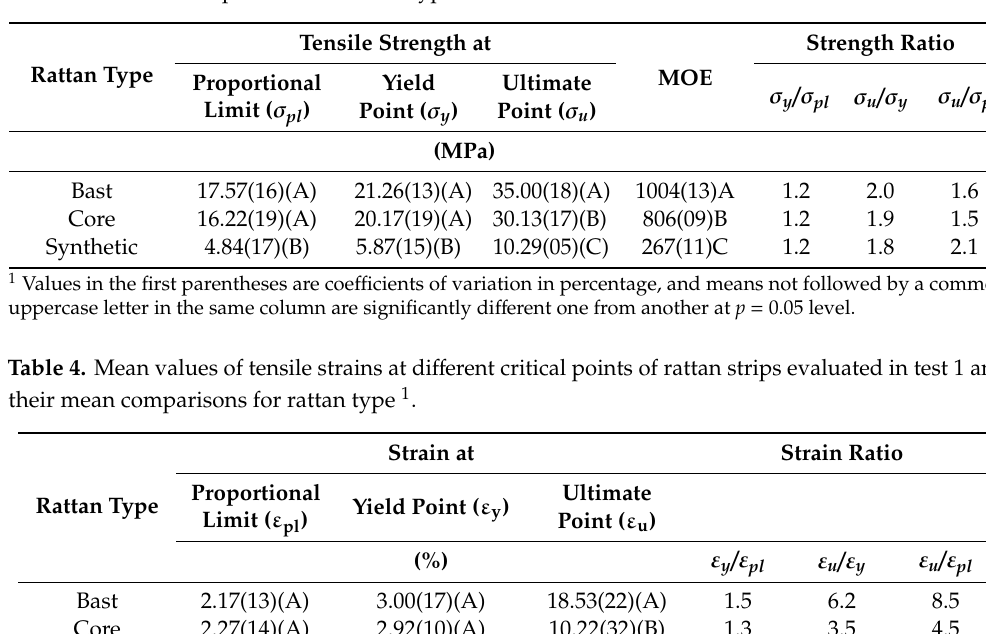
Table 4. Mean values of tensile strains at different critical points of rattan strips evaluated in test 1 and their mean comparisons for rattan type 1 .